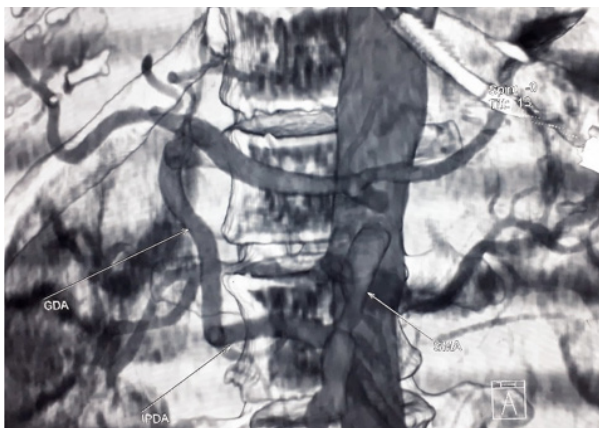
Figure 3: Computed Tomographic Angiography 3D reconstruction showing thrombus in Superior Mesenteric